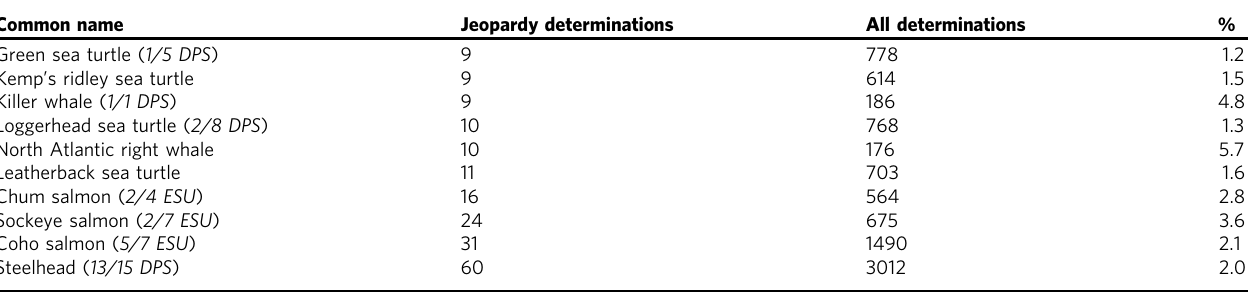
Table 2 The ten species with the greatest number of jeopardy determinations in formal NMFS section 7 consultations between 2000 and 2017